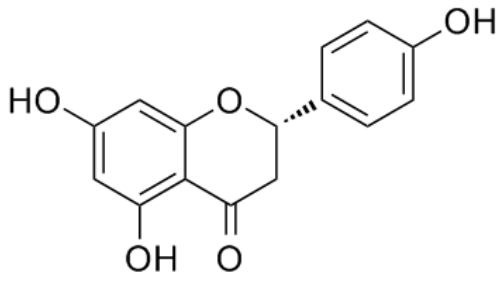
Figure 1. Chemical structure of naringenin.